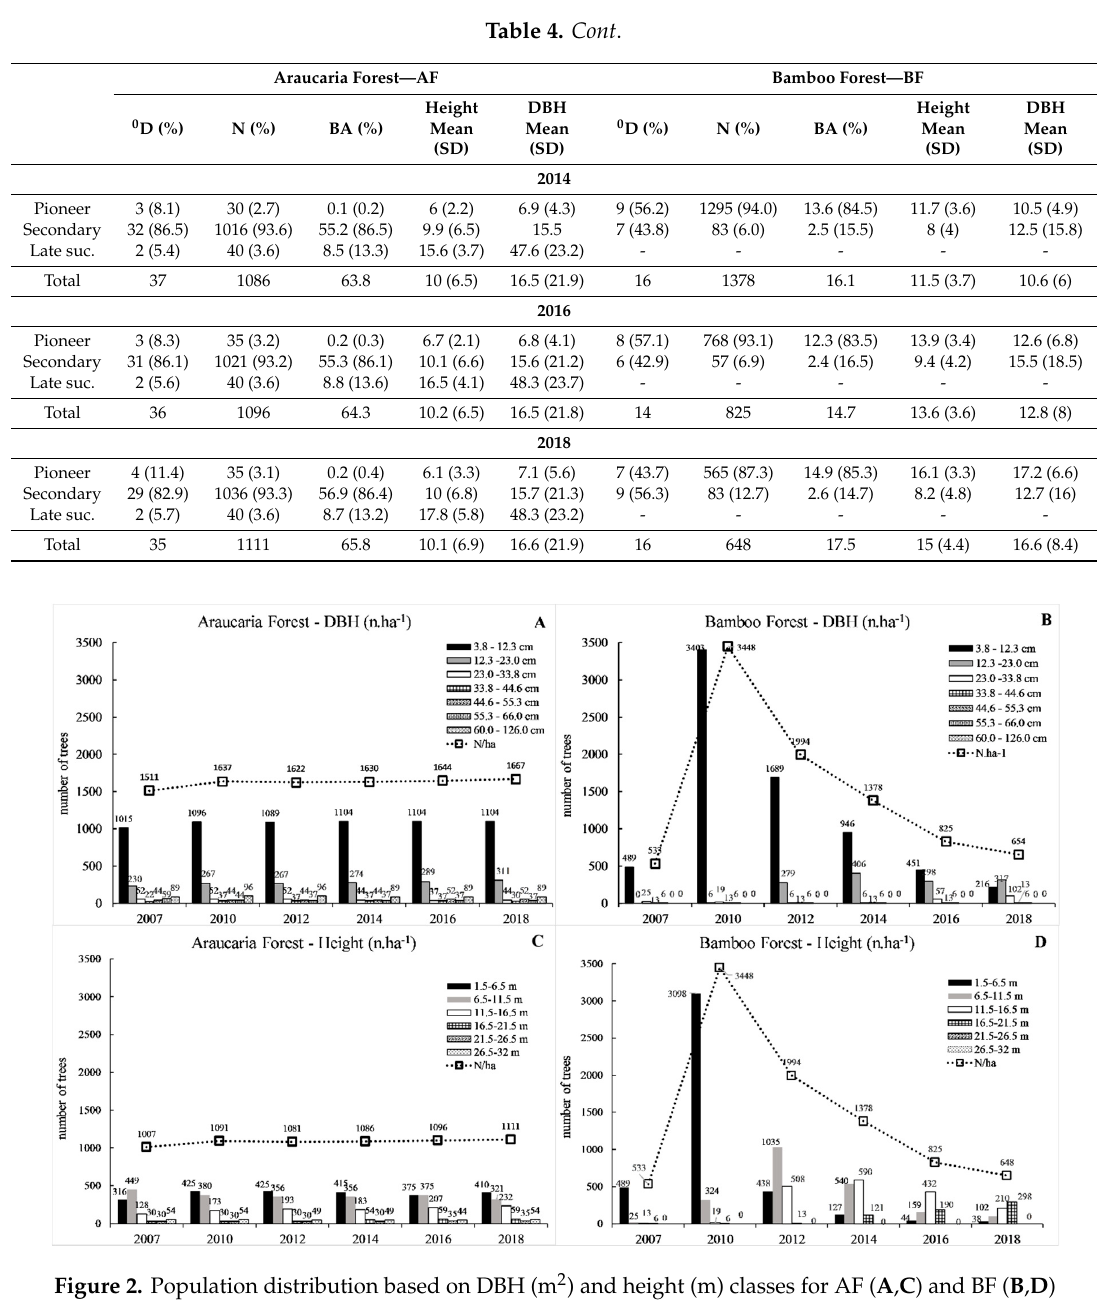
Figure 2. Population distribution based on DBH (m 2 ) and height (m) classes for AF ( A , C ) and BF ( B , D ) and total density (n ha − 1 ) between 2007 and 2018.